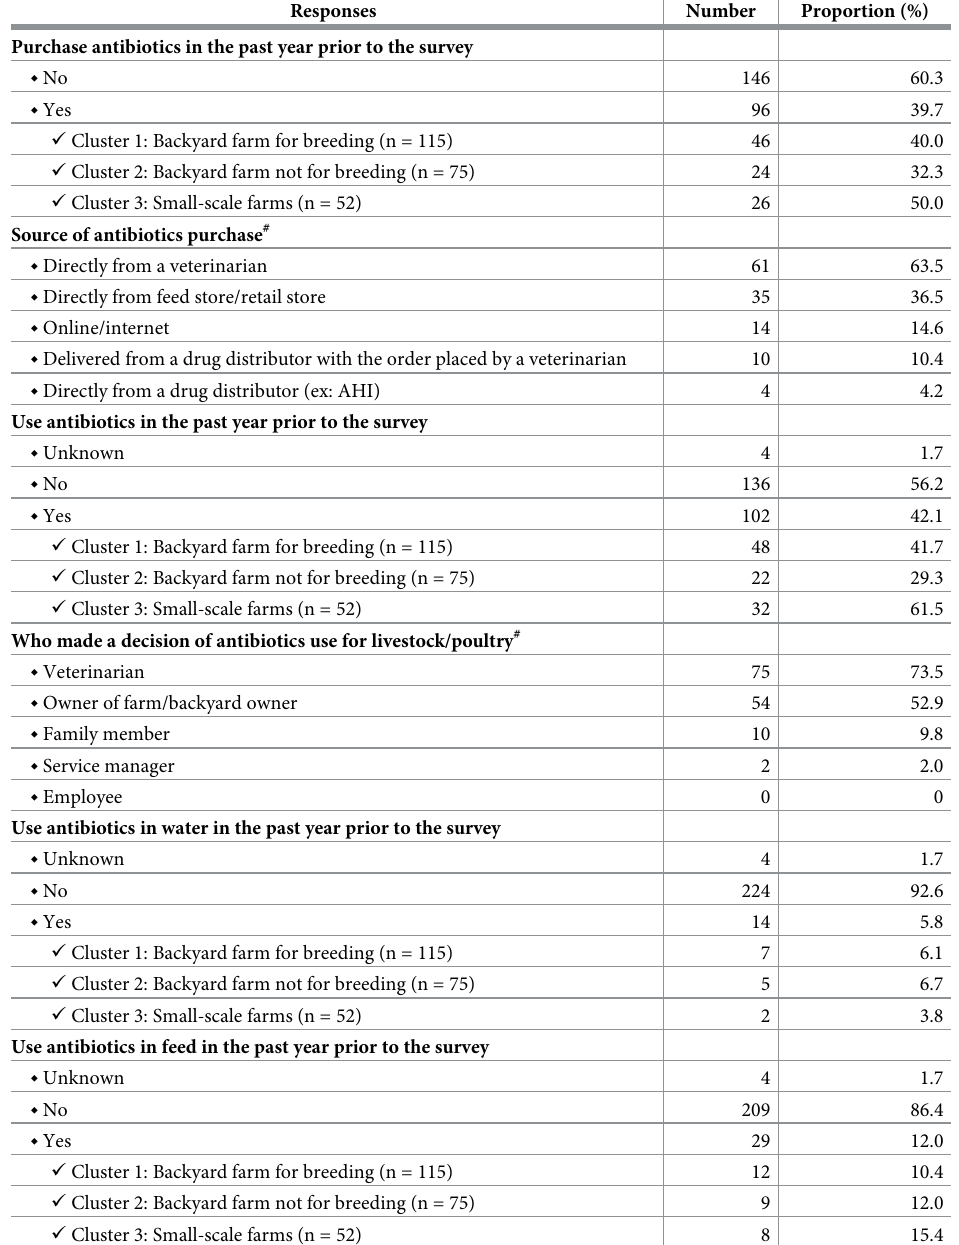
Table 2. Summary of antibiotics use of the survey respondents (n = 242).